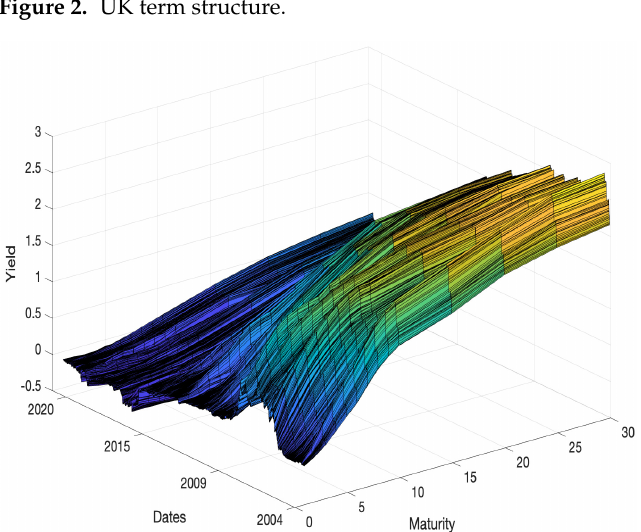
Figure 3. Japan term